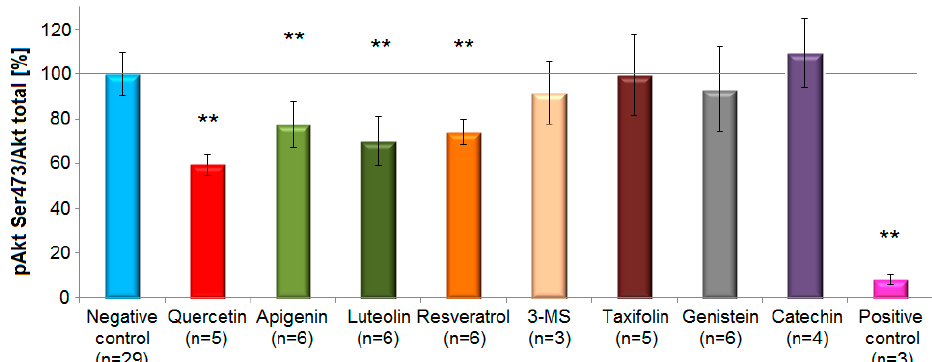
Figure 6. Effects of selected polyphenols on Akt-phosphorylation at Ser473 site in EA.hy926 cells according to the Western blot analysis. Columns represent mean and standard deviation (%). The flavonol quercetin, the flavones luteolin and apigenin, and the stilbenoid resveratrol, caused a statistically significant reduction in Akt-phosphorylation compared to the control (** p < 0.01,